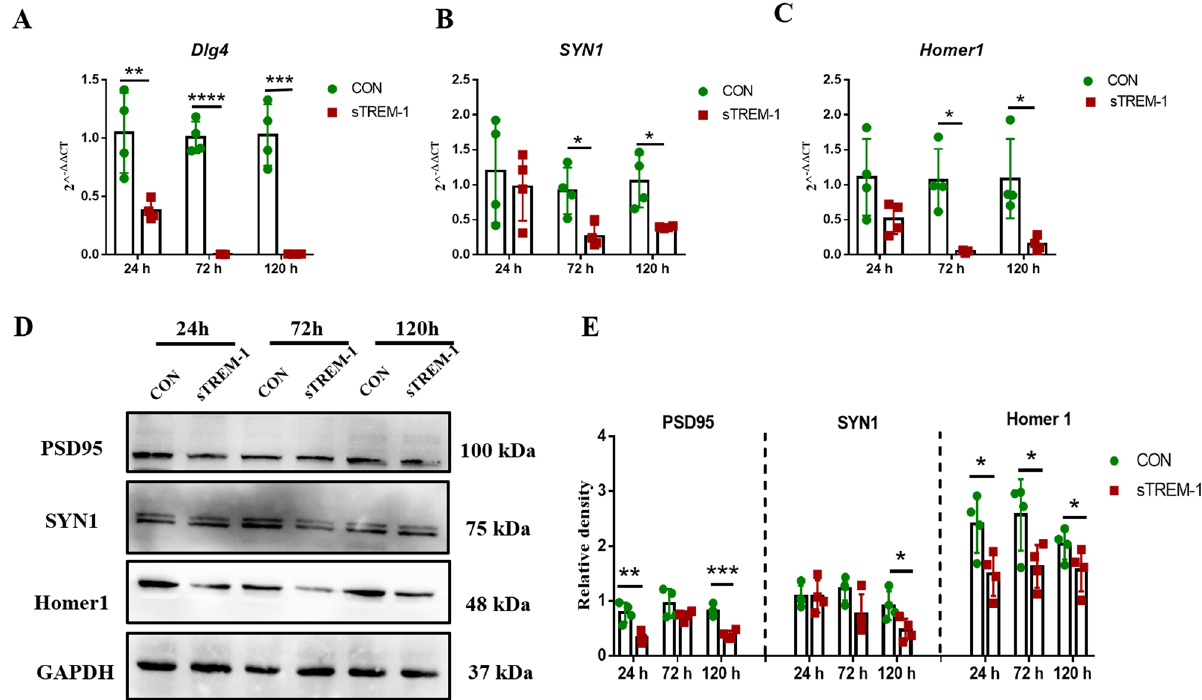
Figure 2. sTREM-1 reduces the expression of synaptic markers in the hippocampus of mice. (A) The mRNA expression levels of Dlg4 in mouse hippocampus detected by Q-PCR, n = 4. (B) The mRNA expression levels of SYN1 in mouse hippocampus detected by Q-PCR, n = 4. (C) The mRNA expression levels of Homer1 in mouse hippocampus detected by Q-PCR, n = 4. (D) Representative western blot images of PSD95, SYN1, and Homer1 protein expression in mouse hippocampus, n = 4. (E) Quantitative analysis of PSD95, SYN1 and Homer1 protein level in mouse hippocampus, n = 4. Data are presented as means ± SEM of at least three separate